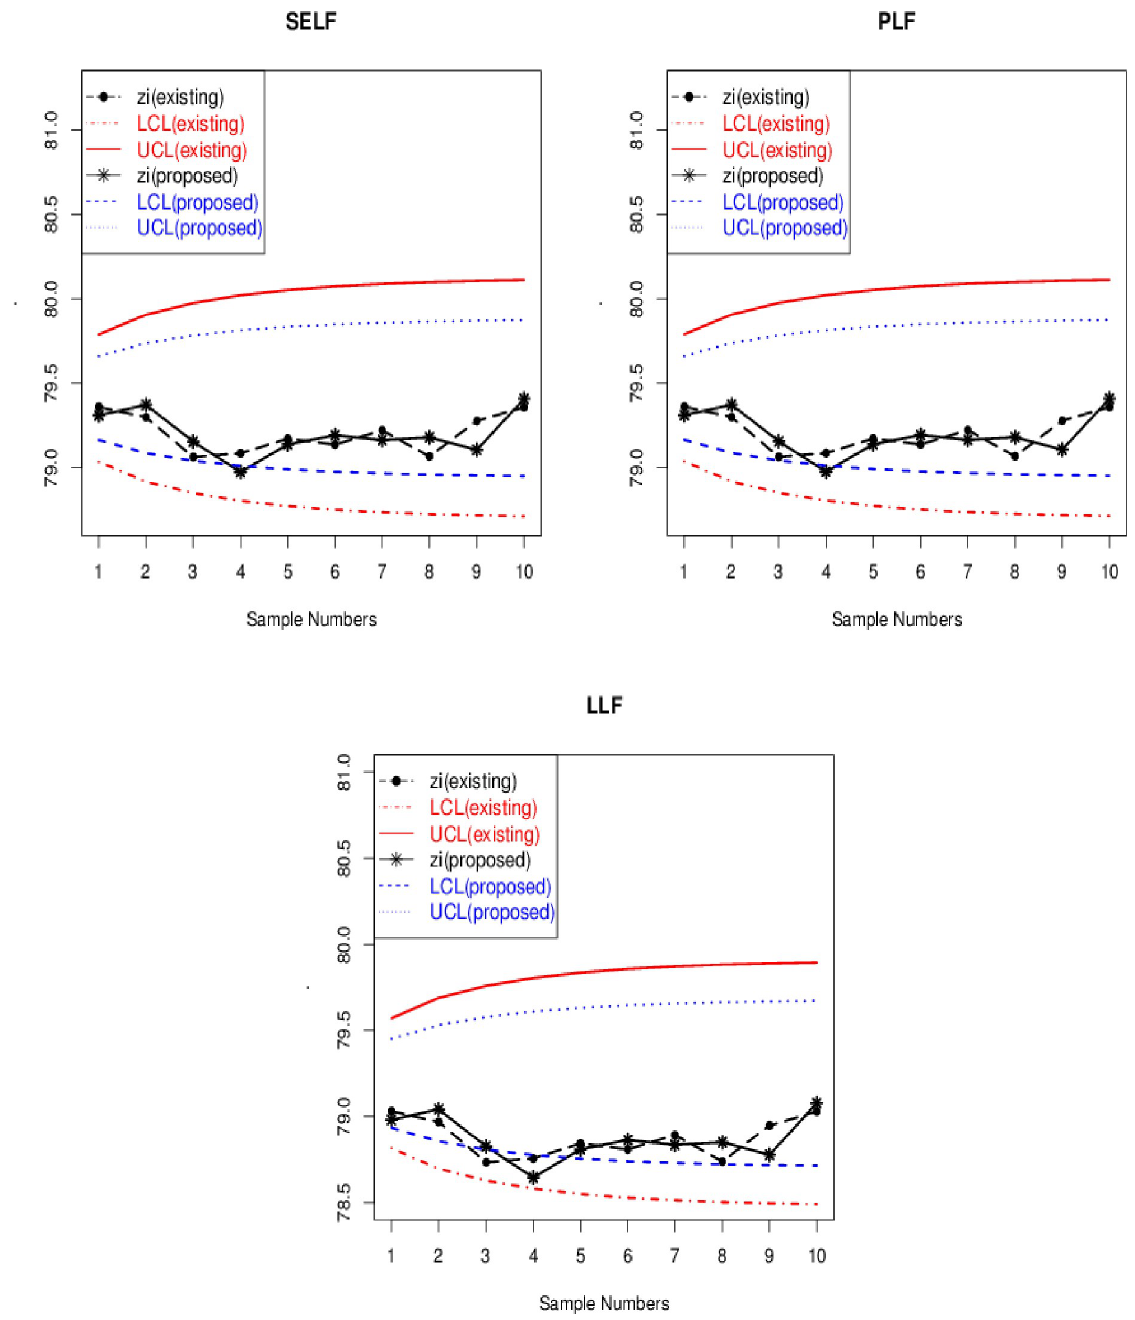
Fig 8. Phase-II graphical display of illustrative example of golf ball bounces to proposed Bayesian modified-EWMA chart and existing Bayesian EWMA under SELF and PLF.